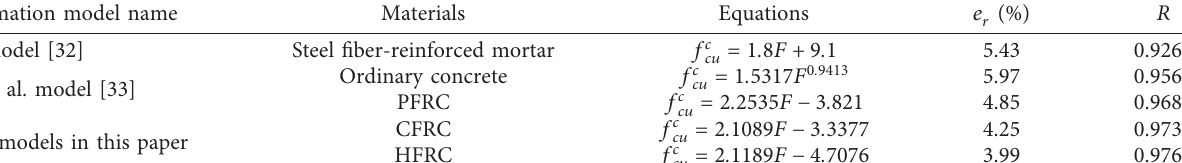
Table 13: Models for estimating compressive strength of in-place concrete postinstalled pull-out test. Estimation model name